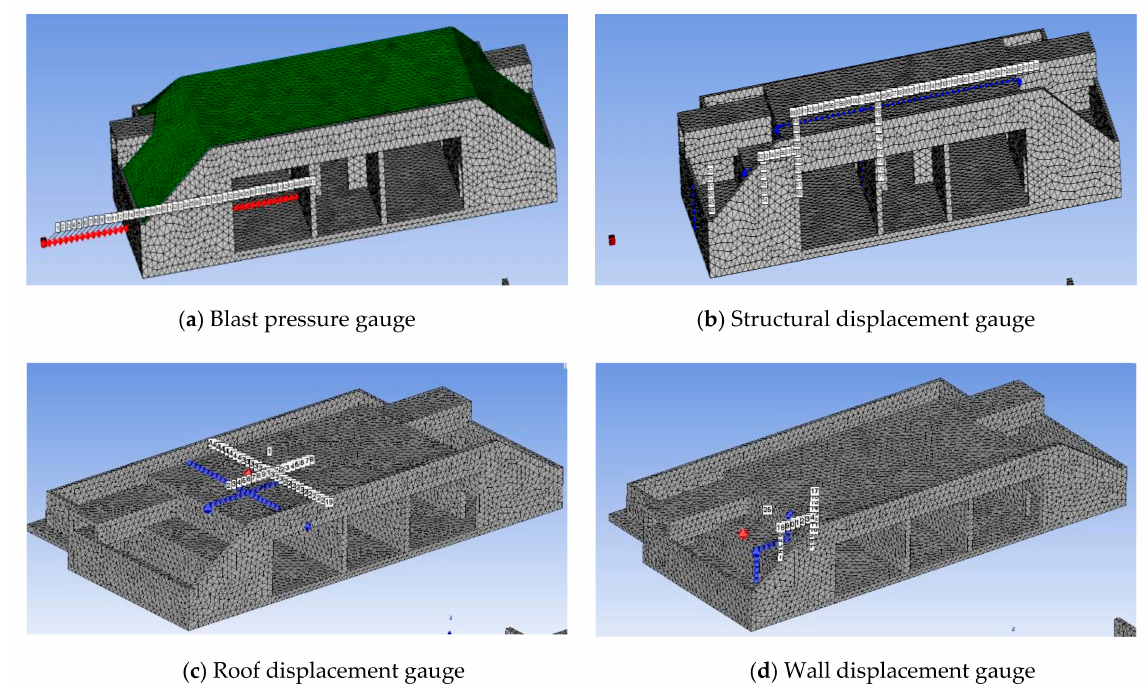
Figure 7. Gauge locations to measure blast pressure and structural